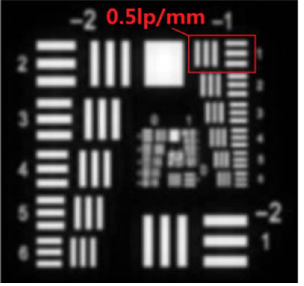
Figure 6. Simulated imaging without cophasing error.